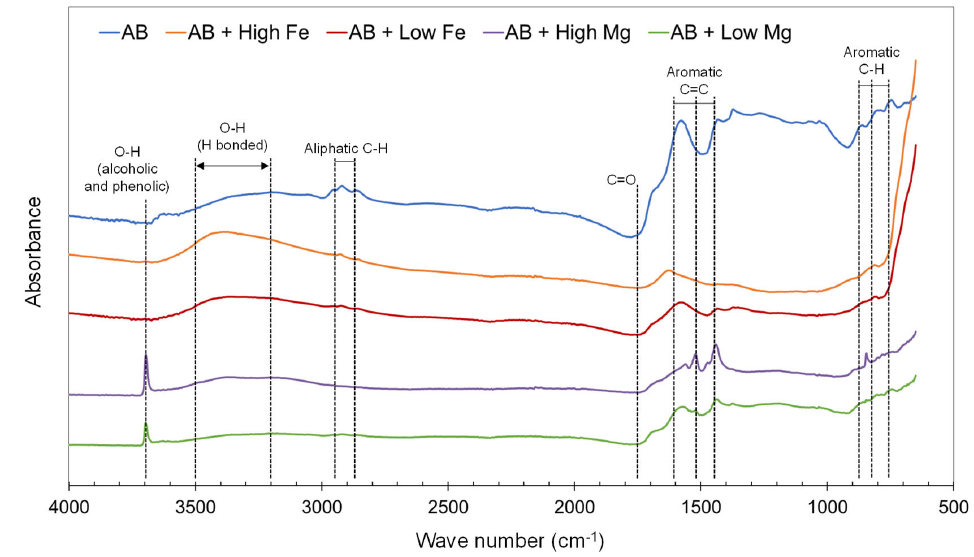
Figure 4. Fourier transform infrared (FTIR) spectra of avocado seed biochar (AB).